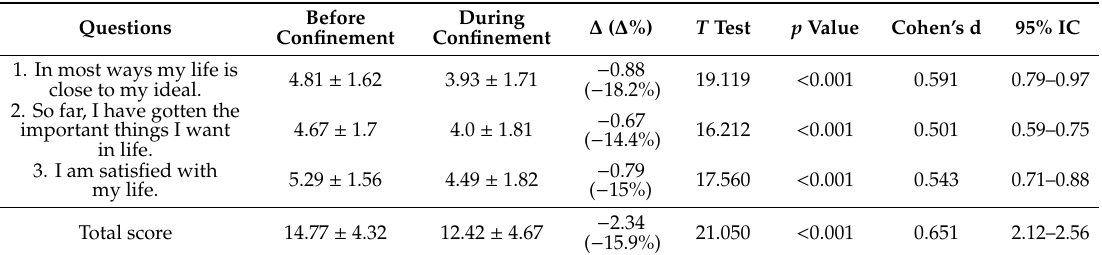
Table 4. Responses related to Short Life Satisfaction Questionnaire—Lockdowns (SLSQL) before and during home